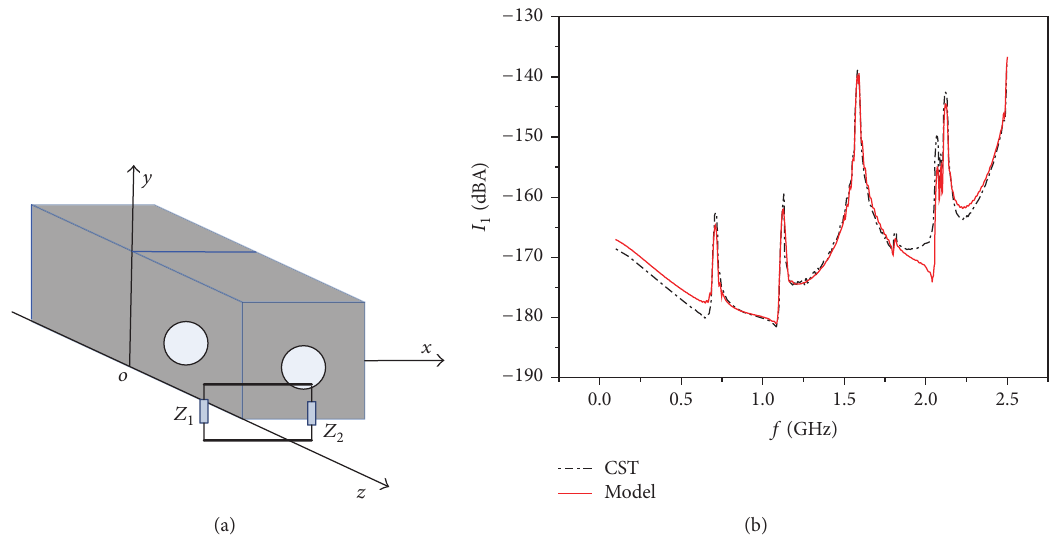
Figure 14: (a) The geometry of the enclosures with covered circular apertures in multiple sides. (b) Electric current induced at termination load 𝑍 1 for apertures in multiple sides from the analytical model and the